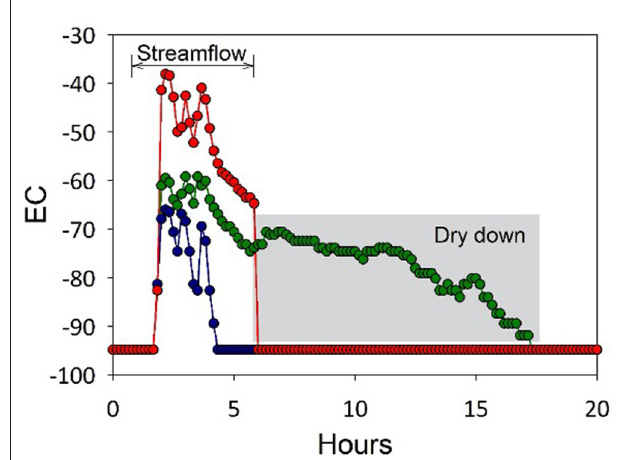
FIGURE 2 | Typical electrical conductivity (EC) profile for a runoff event at a monitoring reach. Each data set (red, green, and blue) represents a different sensor at a single reach. The onset of runoff is marked by a rapid increase in EC (red and blue). The end of streamflow can be identified by either EC returning to − 94, the baseline reading, or by an inflection in the rate of change in EC to a less steep slope, indicative of soil drying conditions (green).